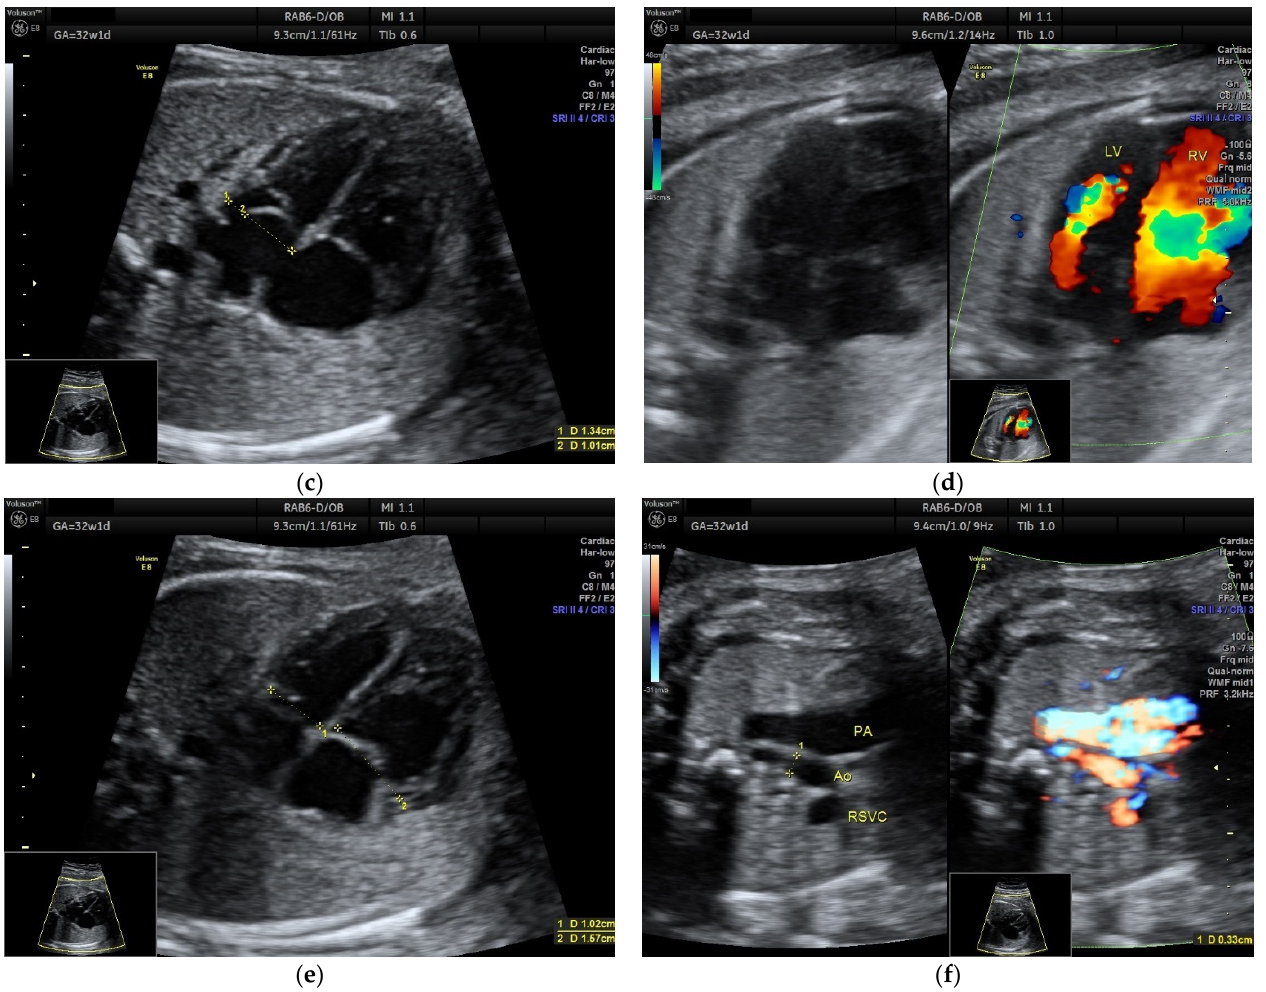
Figure 2. The second case is a 24-year-old G1P0, without priors, that presented at 21w1d for her second trimester screening scan. An atrial septal aneurysm was also demonstrated (ASE index = 0.70) ( a ), with normal LV inflow ( b ). At 32w1d, the foramen ovale flap was making a cyclical contact with the mitral valve, almost covering it (ASE index = 0.75) ( c ), and significantly reducing the LV inflow ( d ). This diminished preload had led to a thinner LV (cardiac chamber asymmetry, RV/LV = 1.53) ( e ). The aortic arch had an anterograde flow but was significantly smaller than in the second trimester (aortic isthmus Z-score = − 2.03) ( f ), supporting further evidence of reduced LV output (Video S1). No PACs were noted until delivery. Due to the suspected aortic arch hypoplasia, the patient delivered in a third-level maternity, where neonatal cardiovascular surgery was available on site. A baby boy weighing 3690 g was delivered by C-section at 39 w, with good postnatal adaptation. The transthoracic echocardiography performed in the early neonatal period showed normally sized LV and aortic arch, while the foramen ovale closed incompletely, with a double interatrial communication. There was also a suspicion of aortic valve malformation, which was not confirmed at the 6 months follow-up, when only a 2.5 mm patent foramen ovale was present. ASE index, atrial septal excursion index; LV, left ventricle; RV, right ventricle; PAC, premature atrial contraction; PA, pulmonary artery; Ao, aorta; RSVC, right superior vena cava.